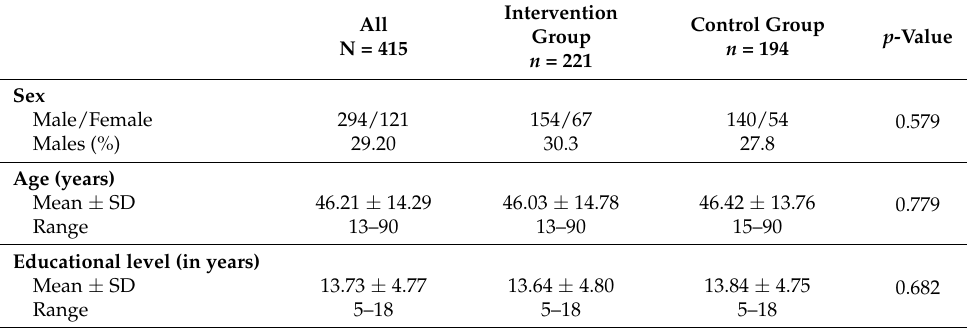
Table 1. Characteristics of people who contacted the help desk “In Ascolto” of the Clinical Psycho- logical Service.